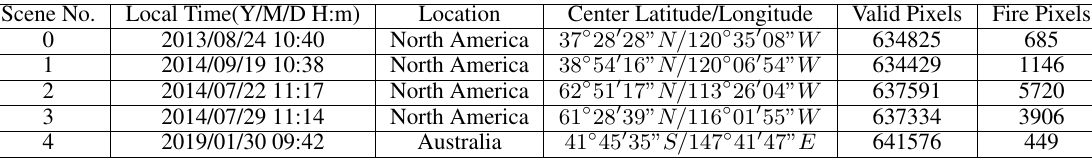
Table 2. Statistics of scenes in the study area.